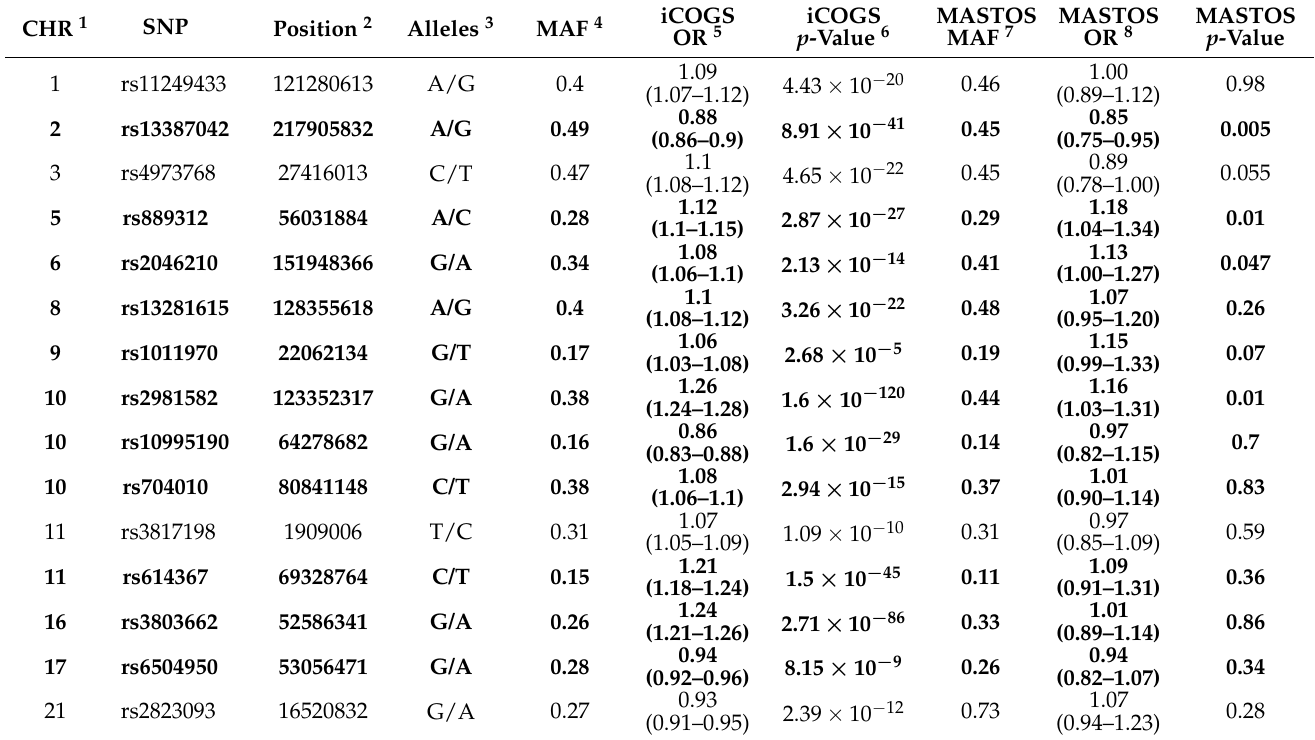
Table 1. Information about the 15 SNPs selected and genotyped in all MASTOS study